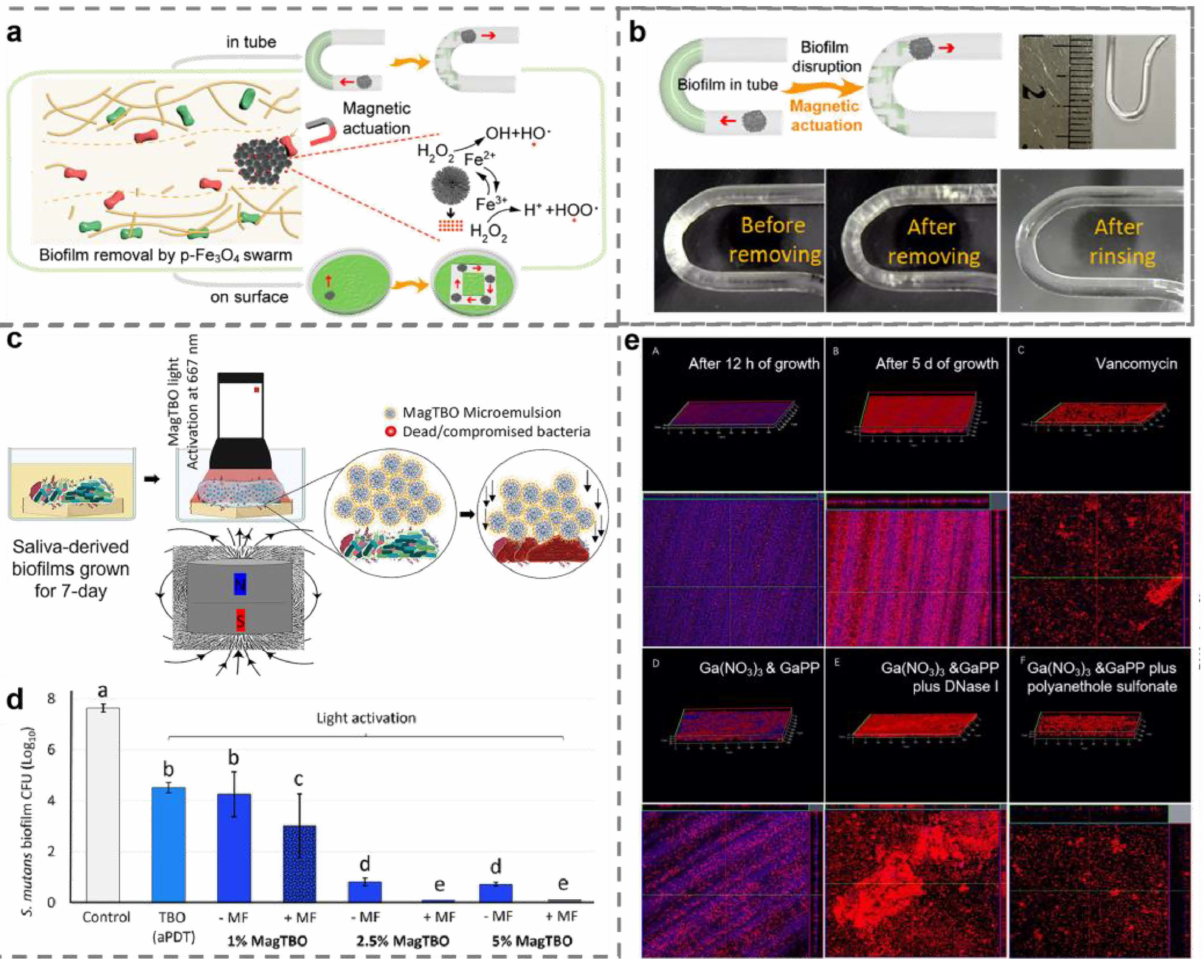
Figure 10. Metal and metal oxide nanomaterials remove biofilm by disrupting extracellular